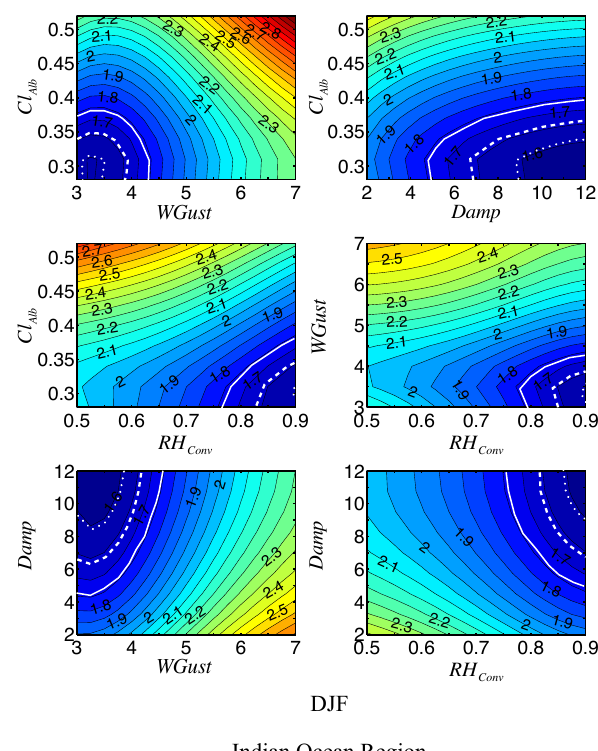
Fig. 11. Pairwise planes of the four-dimensional parameter space showing the root-mean-square precipitation error in mmday − 1 es- timated by the quadratic metamodel over the Indian Ocean basin in December–February. The white dotted (dashed; solid) contours in- dicate regions where the model error increases by 1% (5%; 10%) compared to its minimum value at the parameter optima. Units on axes are ms − 1 for WGust, days for Damp and nondimensional for Cl Alb and RH Conv